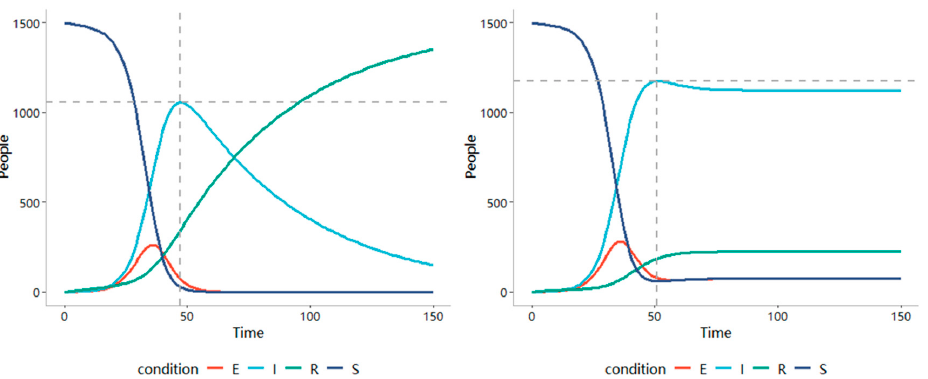
Figure 10. Impact of immune degradation rate ρ (probably of directly changing from R to S ) on the dissemination of CLPP.